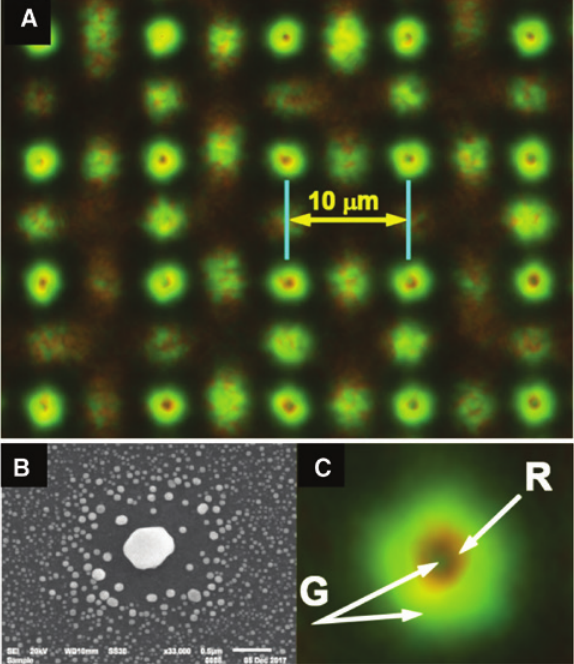
Figure 8: Optical dark-field characterization of the plasmonic gratings. (A) Dark-field optical microscopic images for the sample in Figure 5 and (B and C) correspondence between SEM and optical microscopic dark-field image of a single lattice. Green (G) and red (R) colors can be observed in different areas surrounding and in the center of the gold